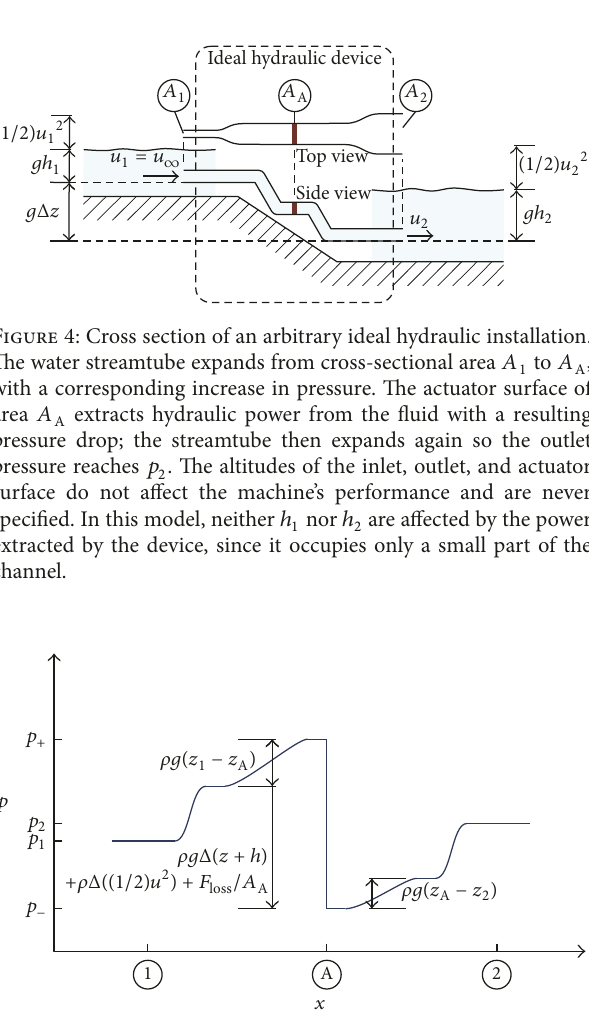
Figure 5: Pressure distribution within the arbitrary ideal machine described in Figure 4. The pressure 𝑝 1 of the inlet water is raised twice: first as its velocity is reduced from 𝑢 1 to 𝑢 and then as the A altitude is varied by 𝑧 1 − 𝑧 . Similarly, downstream of the actuator, A the fluid pressure is raised twice so that flow conditions (2) at the outlet may be attained. The pressure drop across the actuator surface A, described in (14), corresponds to the lumped contributions of net water level altitude change Δ(𝑧 + ℎ) , velocity change (1/2)Δ𝑢 2 , and losses due to drag 𝐹 loss